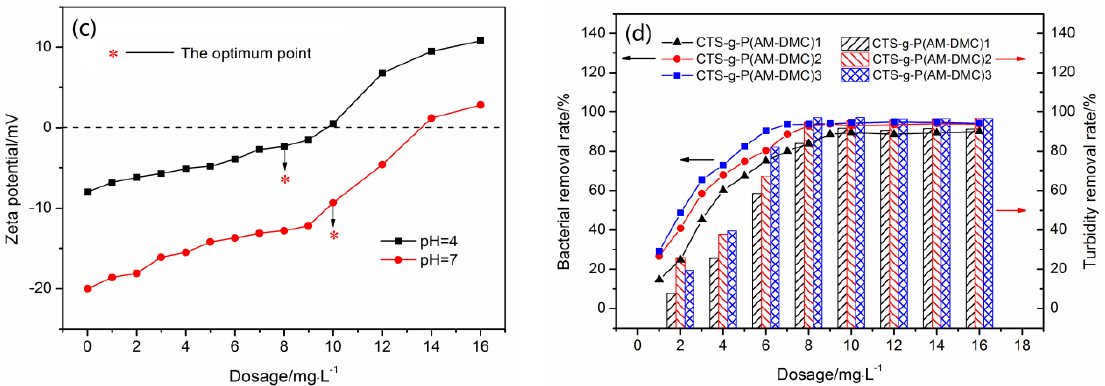
Figure 8. Flocculation and sterilization performance of CTS- g -P(AM-DMC) in Salmonella suspension: ( a , b ) Effect of dosage and pH; ( c ) Zeta potential of the supernatant as a function of flocculants dosages; ( d ) Effect of graft